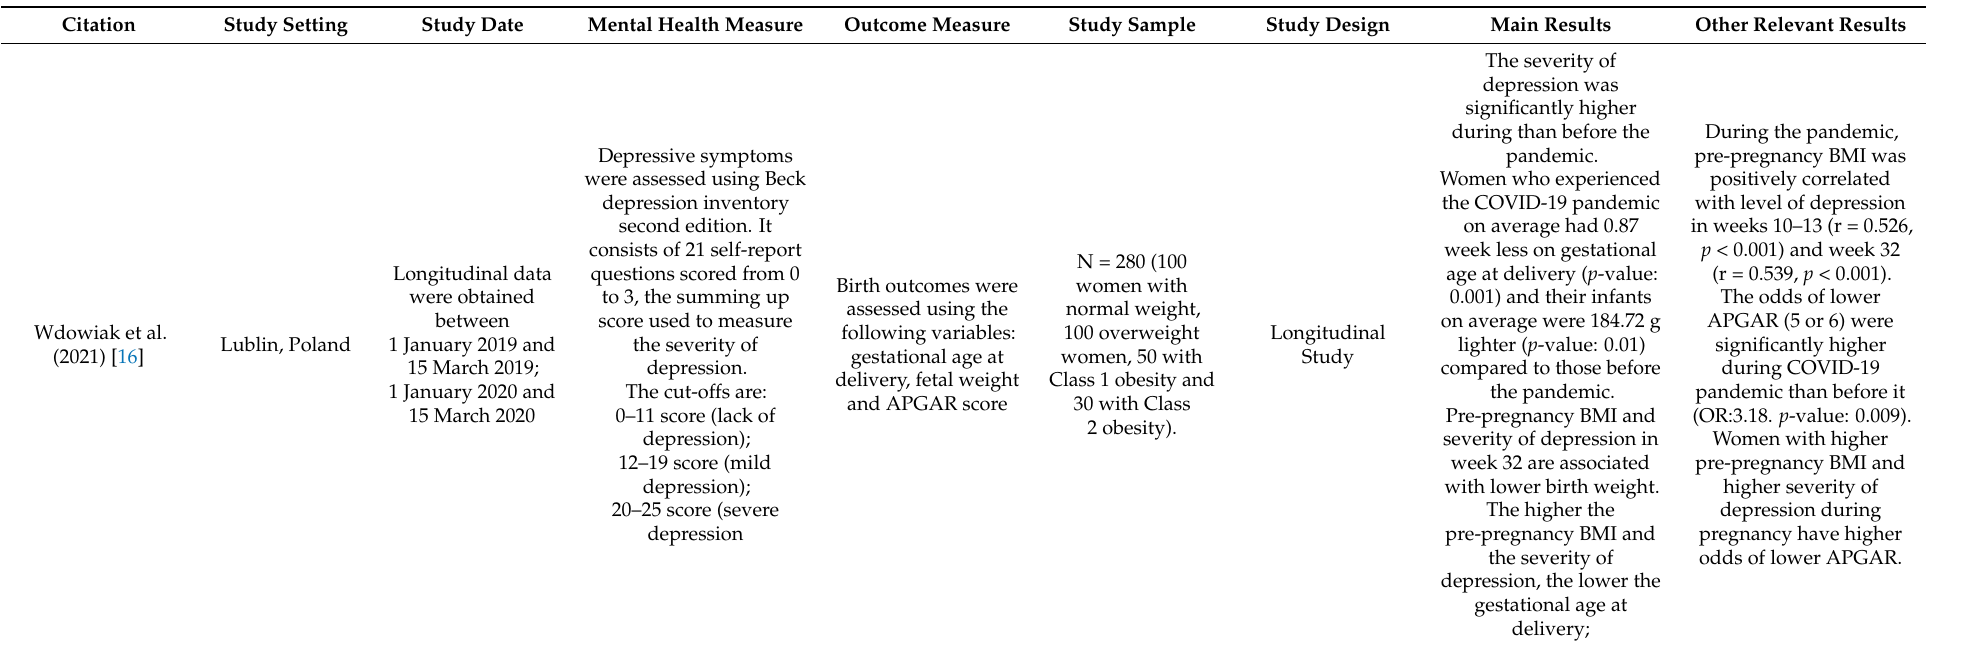
Table 1. Study characteristics of the included